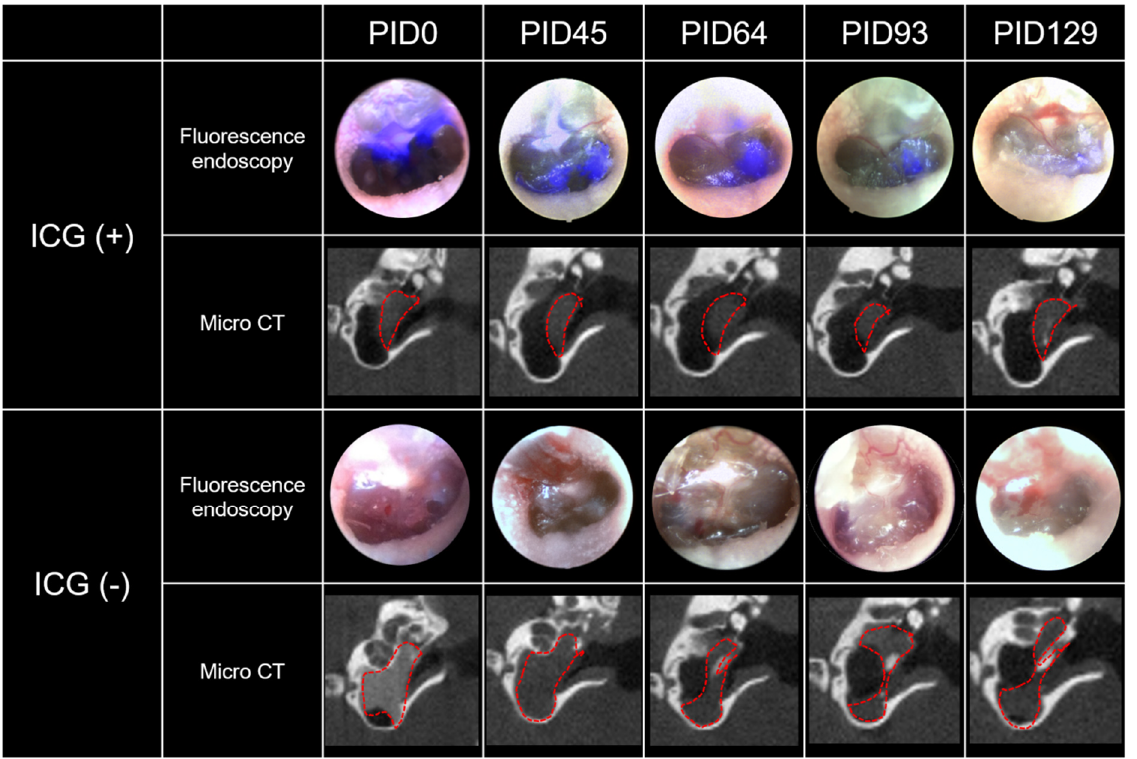
Figure 3. Real-time fluorescence endoscopy of ICG and micro CT in the same ears. The ICG (+) group was injected with 5 mg/mL of ICG in cross-linked HA, whereas the ICG ( − ) group was injected with a control dye (iodinated dye with no fluorescence) in cross-linked HA. The fluorescence was very strong on PID0 in the ICG (+) group. This fluorescence was clearly visible up to PID64 to 93 and became very faint on PID129. Meanwhile, no fluorescence was observed in the ICG ( − ) group. This pattern of fluorescence was independent of the vehicle because a large amount of vehicle was always visible in the middle ear according to micro CT observations.